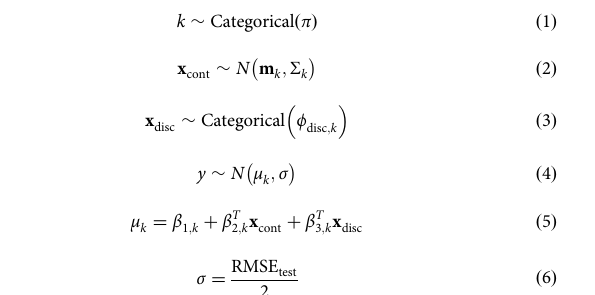
Fig. 2. In this case, x cont represents continuous explanatory variables, such as body composition and blood test data, x disc represents discrete explanatory variables, such as sex, and y represents a response variable, such as the blood pressure value. We denote the measured explanatory values as x and the predictions by the pre- diction model as y . z is the parameter of the mixture components, and k represents each mixture component. The data generative process on a regression task